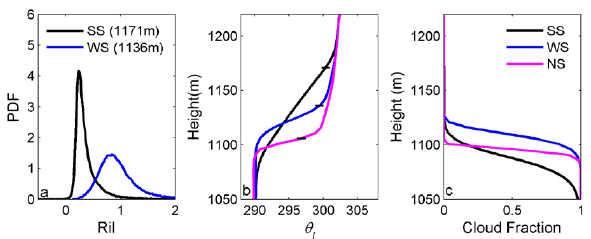
Fig. 7: Characteristics of the inversion layer. (a) PDF of the instantaneous local gradient Richardson number ( R il ); (b) profiles; (c) cloud fraction profiles. The levels at Fig. 7. Characteristics of the inversion layer. (a) PDF of the instan- which the PDF is derived are denoted by horizontal bars on the corresponding θ l pro- taneous local Richardson number Ri l ; (b) ¯ θ l profile; and (c) cloud 𝜽� 𝒍 files. These levels are within the cloud-free sublayers as seen from the and cloud fraction profile. The levels at which the PDF are derived are denoted fraction profiles. The Ri l PDF from NS is not shown due to its large mean value 𝜽� 𝒍 by horizontal bars on the corresponding θ l profiles. These levels are ( ∼ 200) and very broad distribution. within the cloud-free sublayers as seen from the ¯ θ l and cloud frac- tion profiles. The NS Ri l PDF is not shown due to its large mean value ( ∼ 200) and very broad distribution. Fig. 8: Joint PDF of R il with other variables ( q v , θ and w ) in the cloud-free sublayer. The first column is for SS; the second WS; and the third NS. The first row presents Fig. 8. Joint PDF of Ri l with other variables ( q v , θ and w) in the − joint PDF; the second R il − θ ´ ; and the third R il − w´ . cloud-free sublayer. The first column is for SS; the second WS and 𝑹 𝒊𝒍 𝒒′ 𝒗 the third NS. The first row presents Ri l − q 0 v joint PDF; the second Ri l − θ 0 ; and the third Ri l − w 0